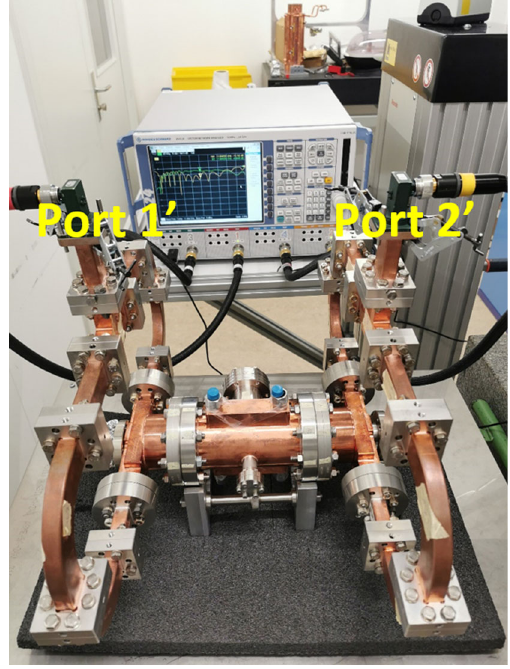
FIG. 23. The full-assembly structure connected with two power splitters (see fourth row of Table II).